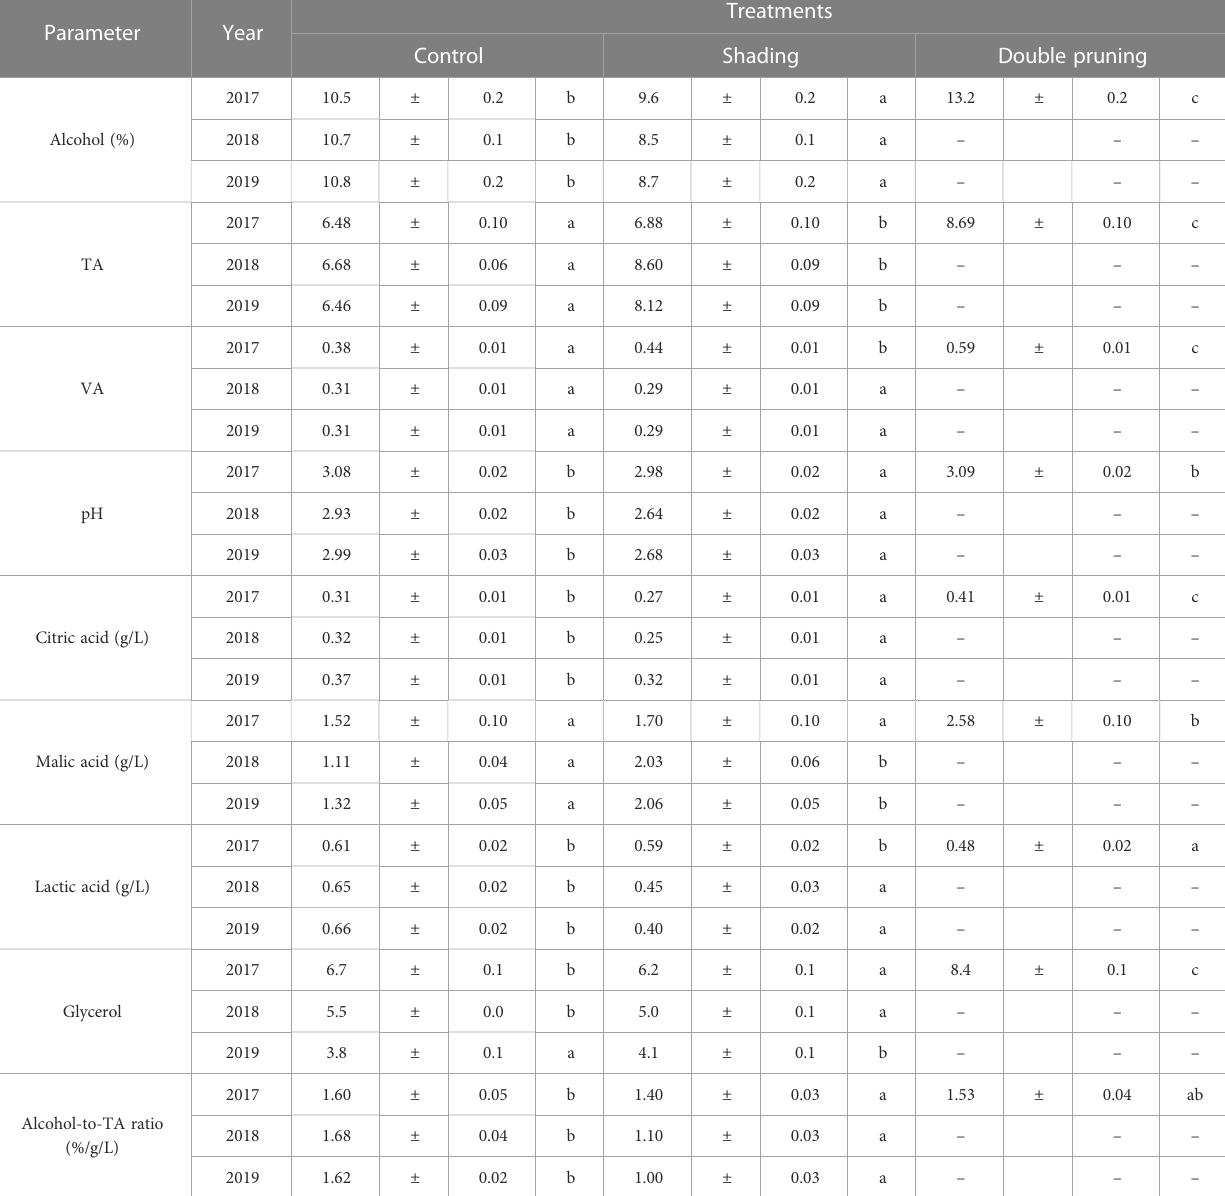
TABLE 3 Average values of wine composition at harvest over the 3 years of the experiment in ‘ Macabeo ’ grapevines subjected to different treatments.